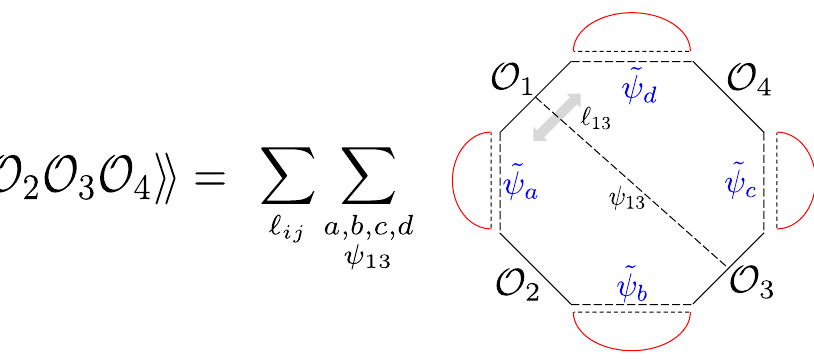
Figure 18 . Hexagonalization of the four-point function on the Wilson loop. In this case, we need to glue together two hexagons and four boundary states. This results in the sum over the boundary states ~ ’s and the sum over the states 13 that stitch the two